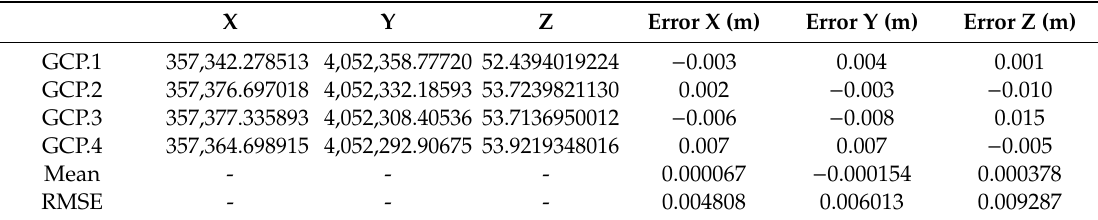
Table 4. Horizontal and vertical errors in connection with GCP points by applying